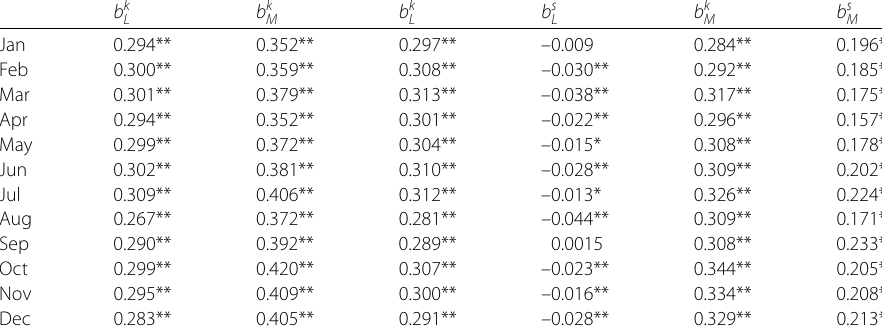
Table 10 Coefficients for multinomial logistic regression of in-degree distribution. The first two columns refer to the regression with the degree as only predictor. The last four columns refer to the regression with also the size as predictor. The superscript indicates the predictors: k for the degree, s for the size. The subscript indicates the risk rating. The stars indicate significance: one star if the p-value < 0.05, two stars if the p-value < 0.01 b k b k b k b s b k b s L M L M L M Jan